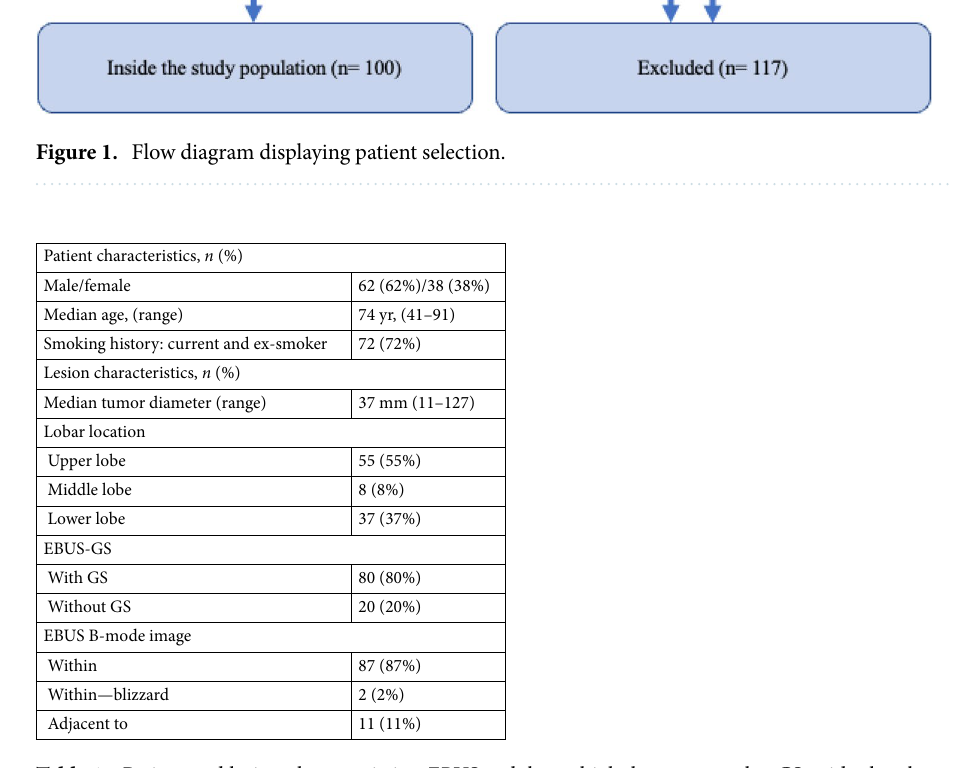
Table 1. Patient and lesion characteristics. EBUS endobronchial ultrasonography, GS guide